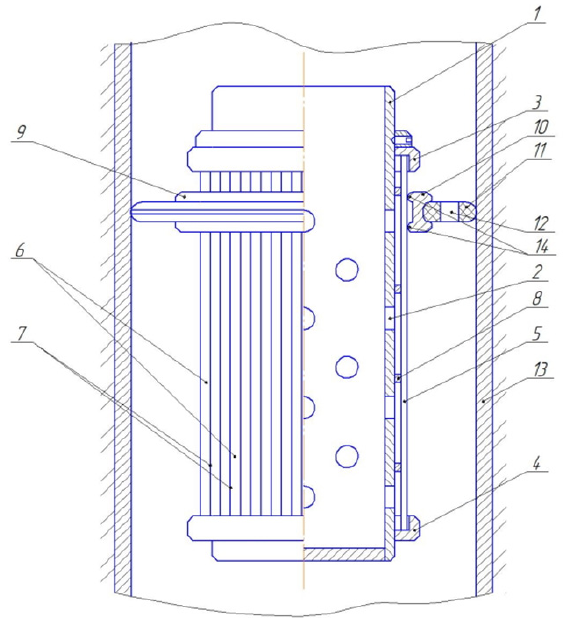
Figure 5. Borehole slotted filter with a movable cleaning device.